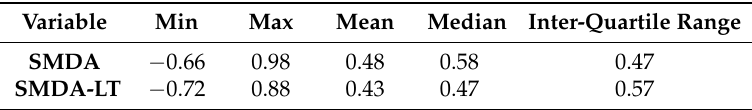
Figure 10. Histograms comparing site by site correlation coefficients for 346 climate stations between PDSI and SMDA ( Left ) and SMDA-LT ( Right ). Table 5. Summary statistics for site by site